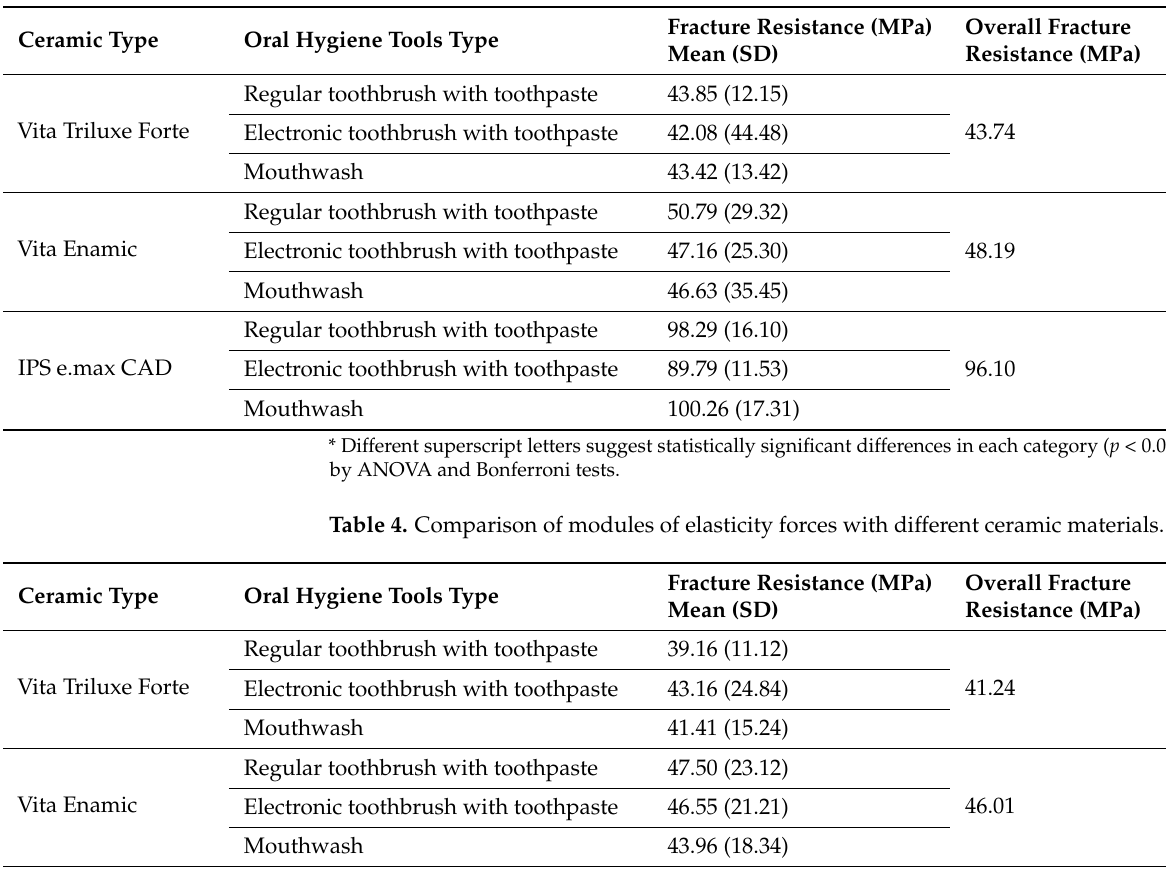
Table 3. Comparison of biaxial fracture forces amongst different ceramic materials.